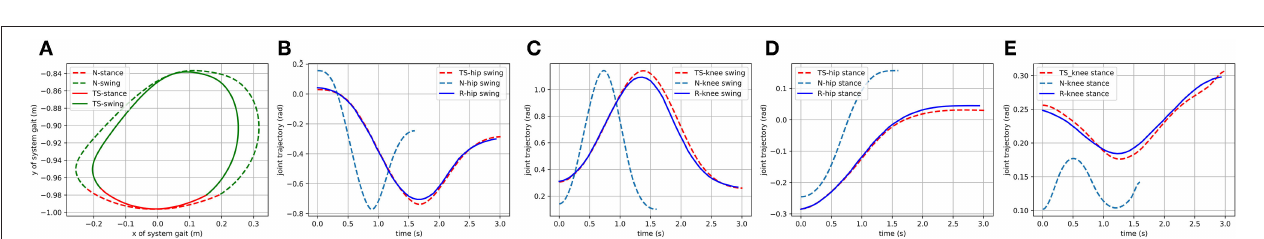
FIGURE 14 | The temporal-spatial scaled gait and joint trajectories. In (A) , the dotted and the solid are the normal and temporal-spatial gaits, including stance and swing phase, and they are labeled as N-stance, N-swing, TS-stance, and T-swing, respectively. (B–E) The data of the actual system are the solid lines labeled starting with R, while the dotted ones are the normal and temporal-spatial joint trajectories marked beginning with N and TS, respectively. The errors of the trajectories between the feedback of the actual system and the planned are